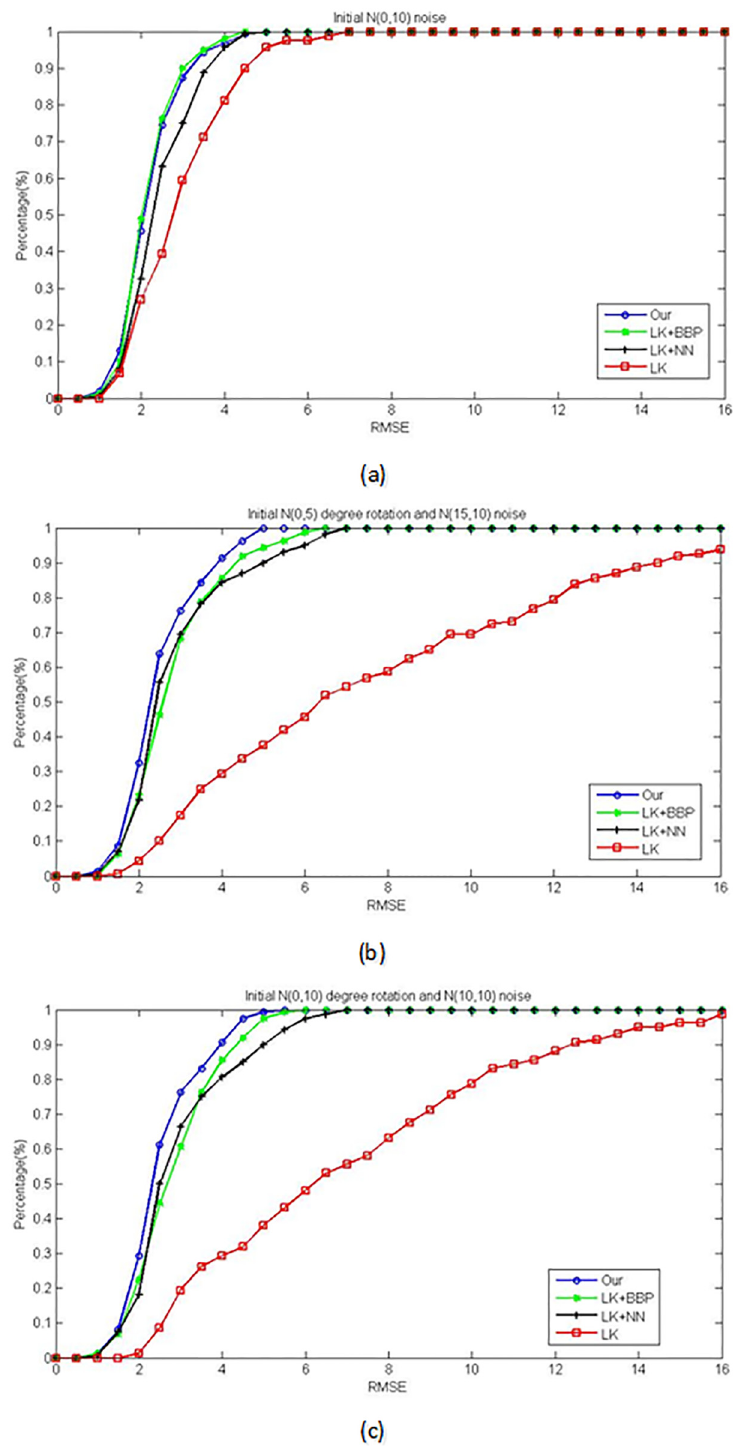
Fig 4. The cumulative RMSE curves with different initial parameters by four methods: Ours (LK +4-PP), LK+BBP, LK+NN and LK. (a) The results with initial Gaussian noise N (0, 10). (b) The results with initial rotated N (0, 5) degrees and randomly perturbed by Gaussian noise N (15, 10). (c) The results with initial rotated N (0, 10) degrees and randomly perturbed by Gaussian noise N (10, 10).